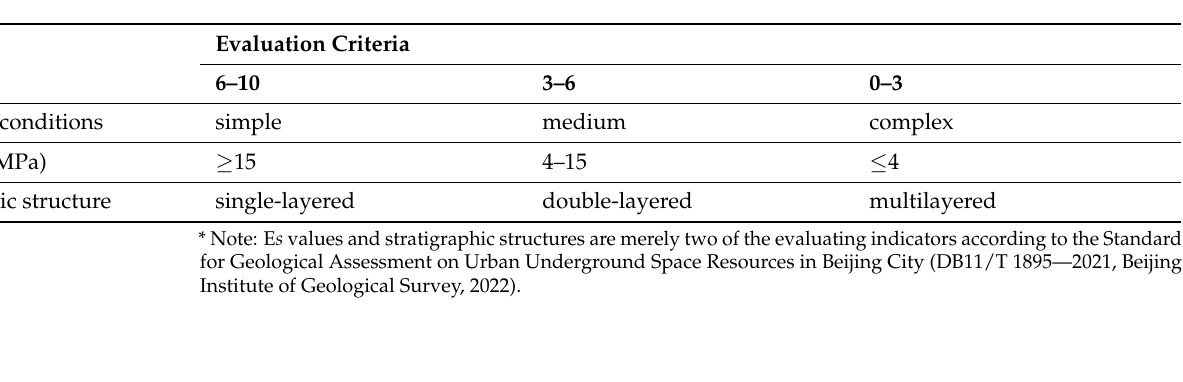
Table 3. E s values and stratigraphic structure considered as evaluation indicators for UUS suitability. The quantification result is divided into three intervals containing 6–10, 3–6, and 0–3, representing simple, medium, and complicated geological conditions